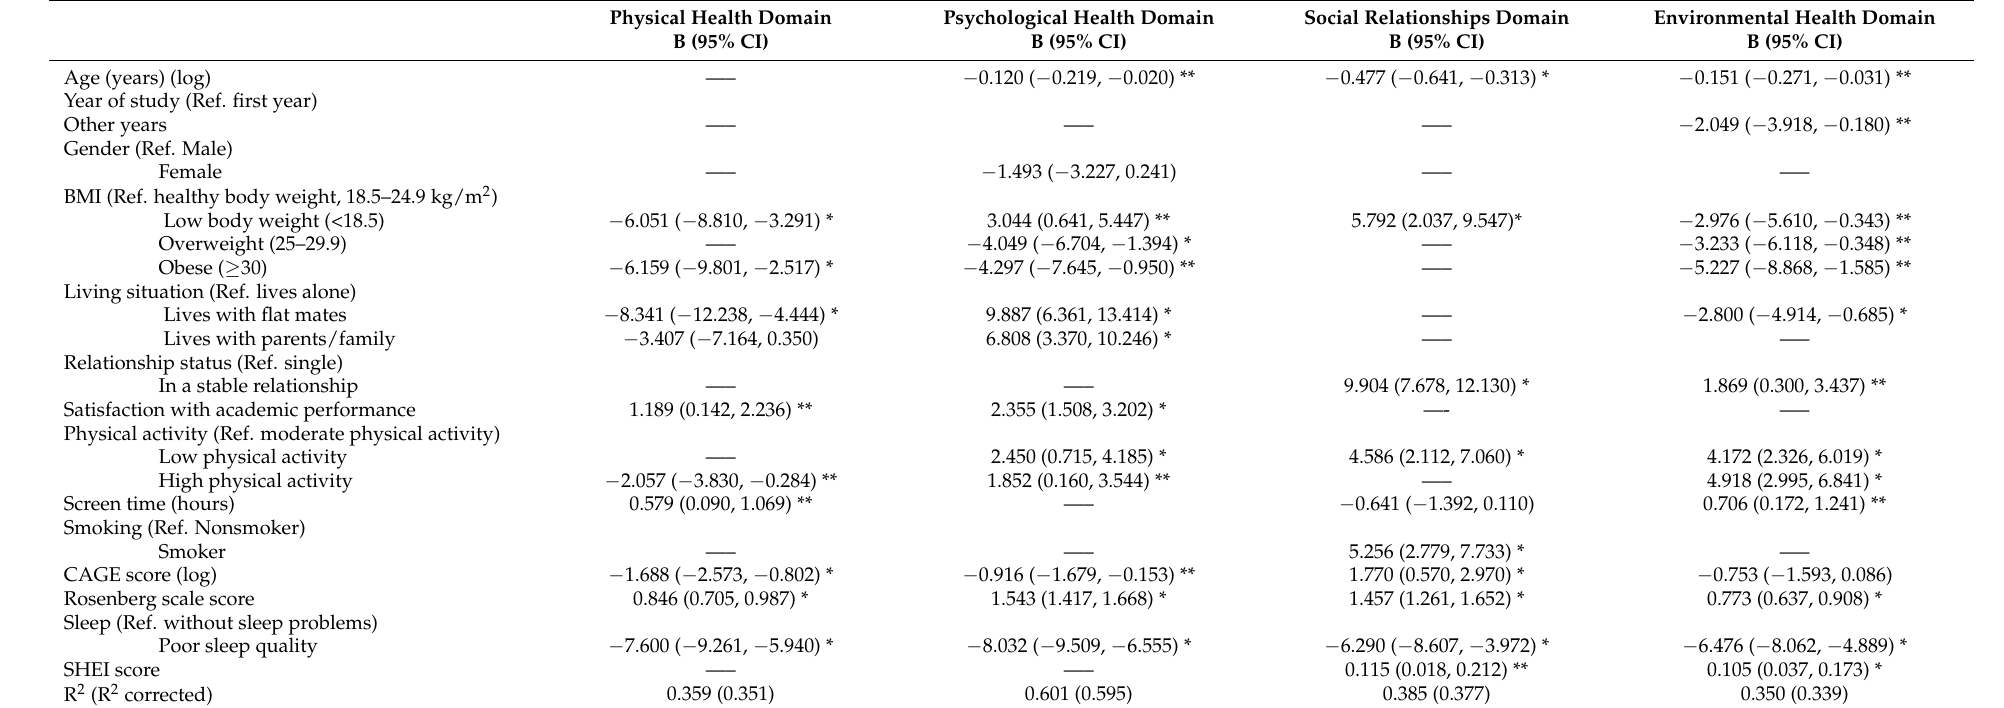
Table 4. Multivariate analysis of factors associated with the different QOL